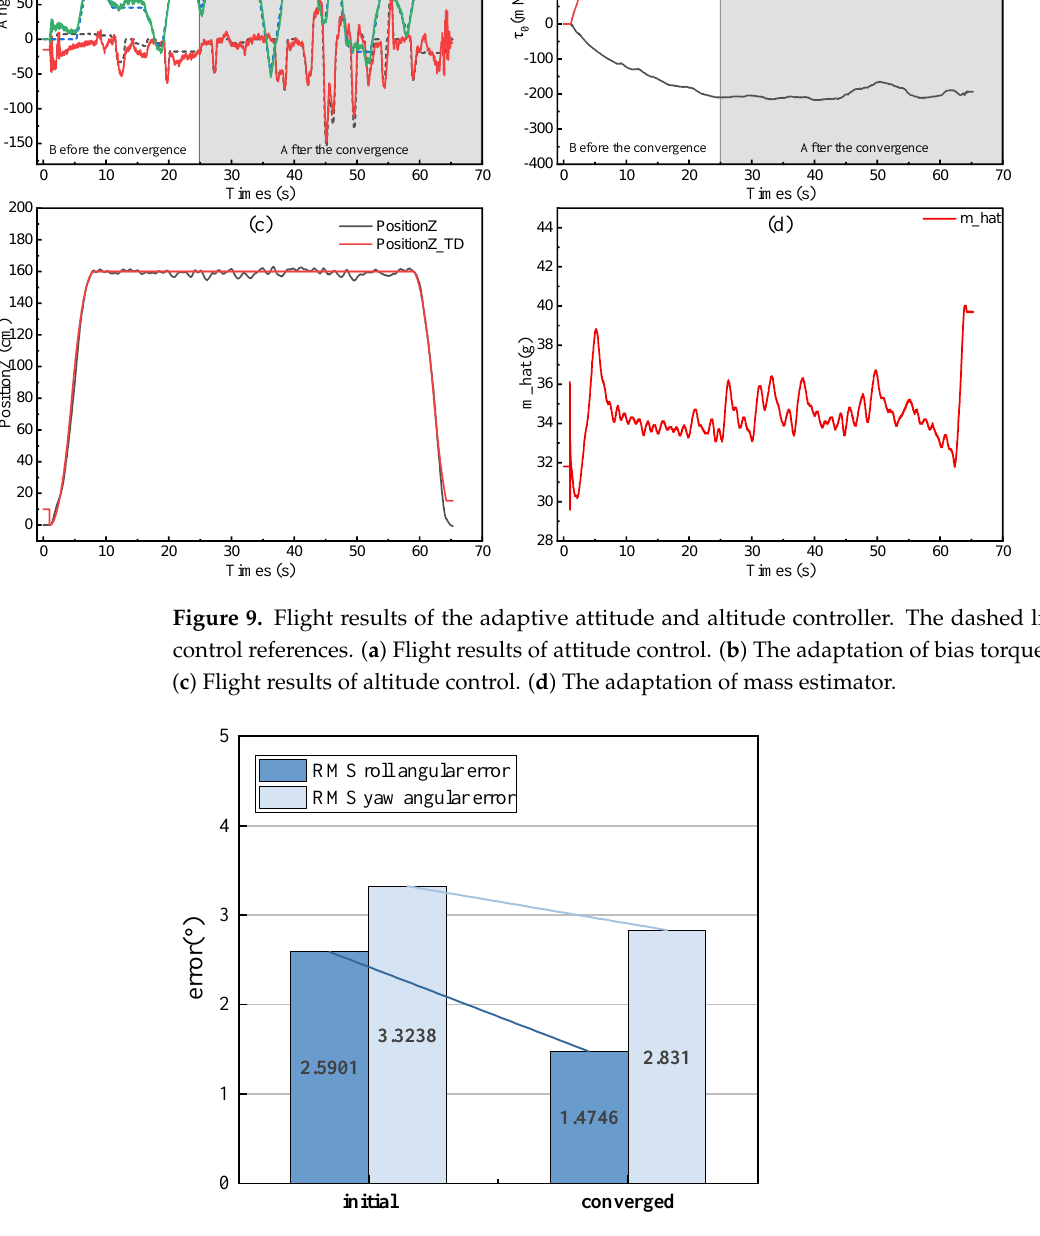
Figure 10. Comparison of RMS angular error before and after adaptive parameter